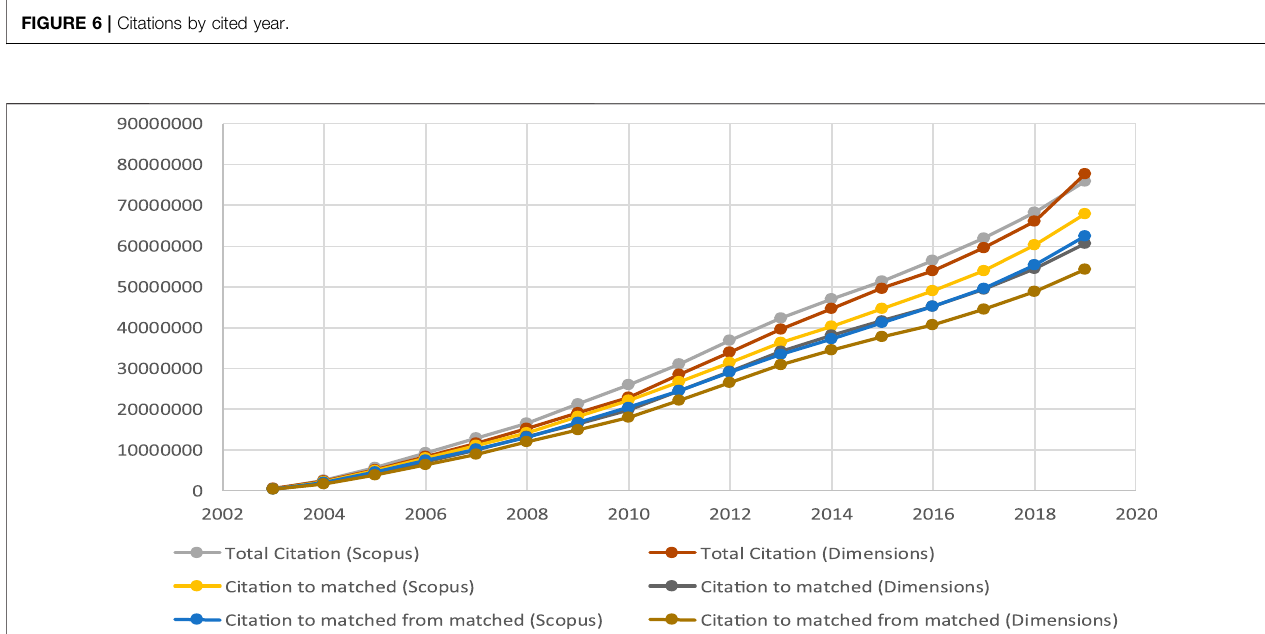
FIGURE 6 | Citations by cited year.